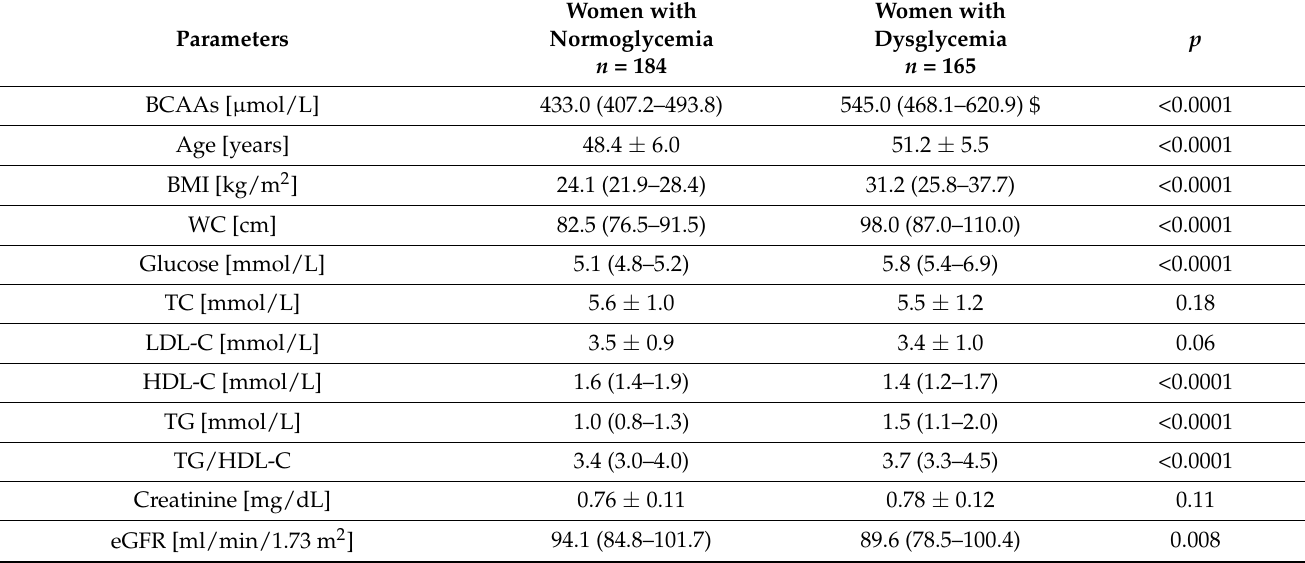
Table 1. Clinical characteristics of the